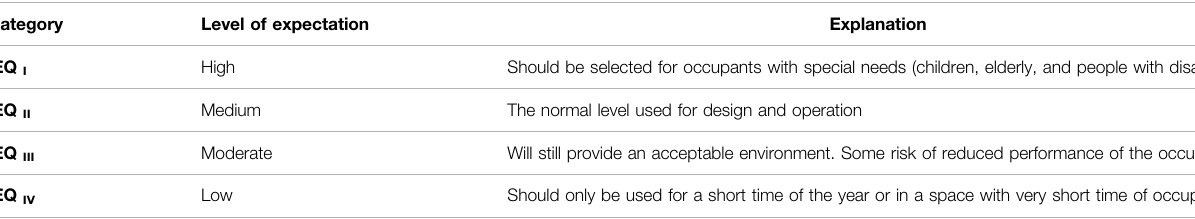
TABLE 1 | Description of the air quality categories in buildings.